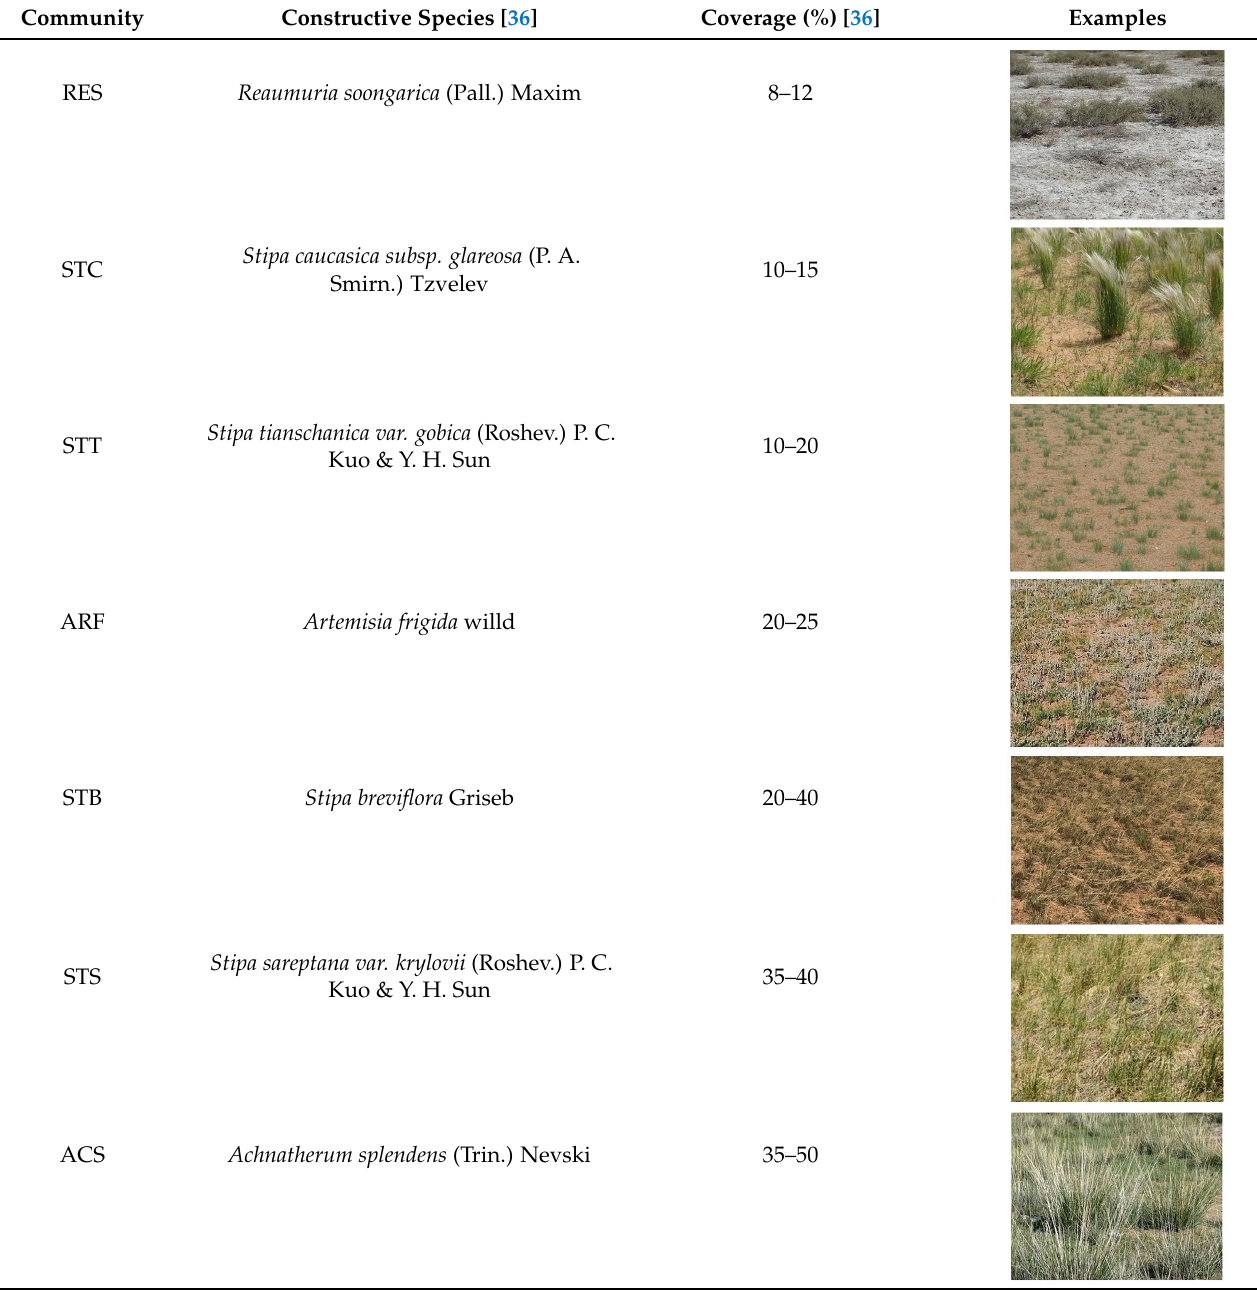
Table 1. Main grassland communities in